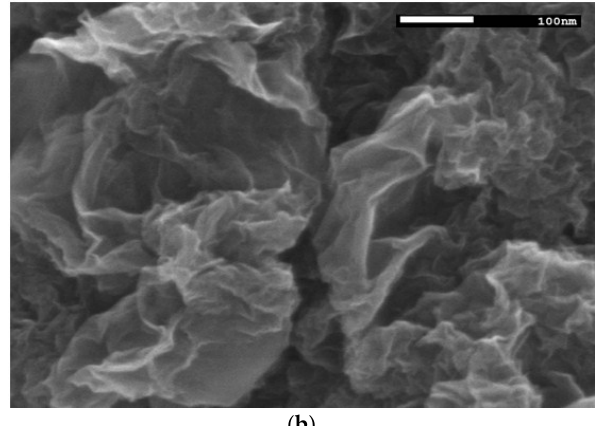
Figure 2. Fourier-transform infrared spectroscopy (FTIR) spectra of graphite, GO and rGO recorded by FTIR spectrometer ( a ) and field emission scanning electron microscopy (FESEM) image of rGO captured at an acceleration voltage of 3.0 kV and 150 k × magnification ( b ).